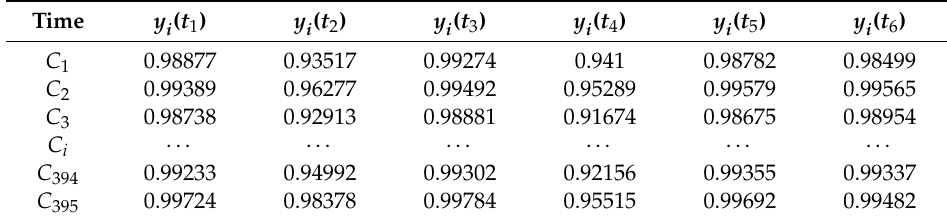
Table 7. Static comprehensive evaluation (SCE) matrix (unit: mm).